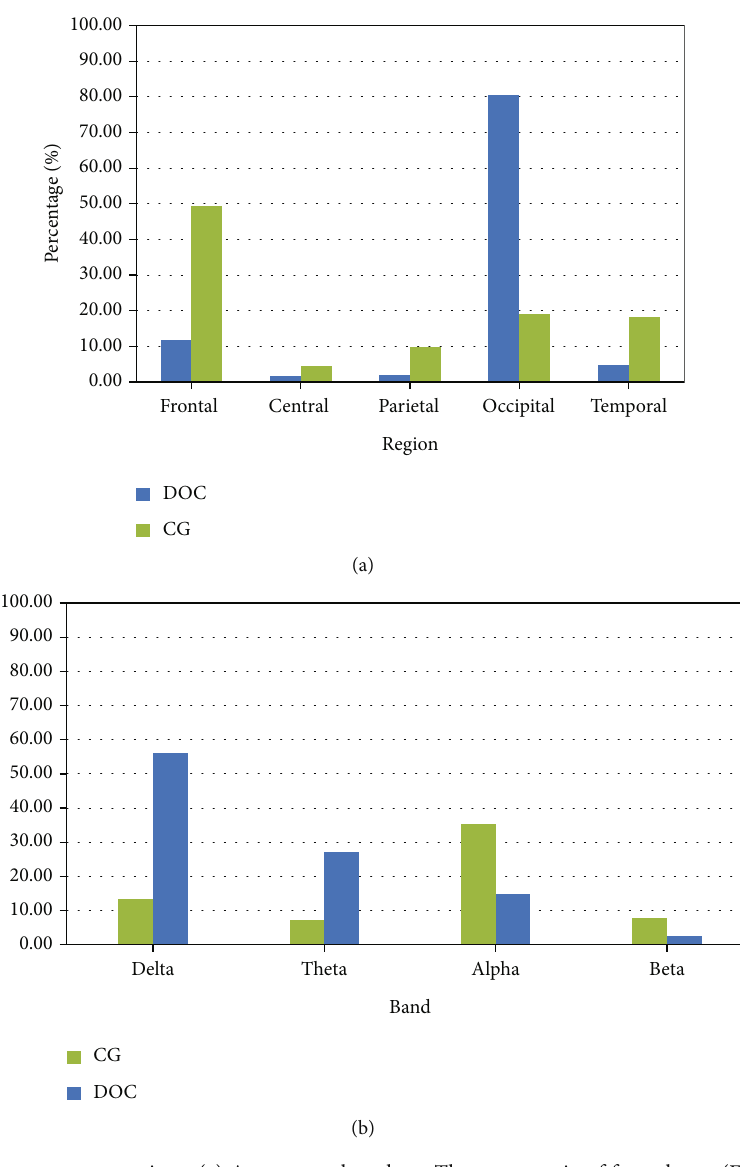
Figure 3: Bar chart of relative power comparison. (a) Area power bar chart. The power ratio of frontal area (Fp1, Fp2, F3, Fz, F4, F7, and F8), central area (C3, Cz, and C4), temporal area (T3, T4, T5, and T6), parietal area (P3, Pz, and P4), and occipital area (O1, Oz, and O2). In the DOC group, the power ratios of frontal, central, parietal, and temporal regions decreased signi fi cantly. (b) Area power bar chart. It can be seen that the proportion of power in delta and theta bands in the DOC group is signi fi cantly higher than that in the CG group, while the proportion of power in alpha and beta bands in the CG group is higher than that in the DOC group, this may be the cause of the DTABR di ff erence. (DOC: disorder of consciousness; CG: control